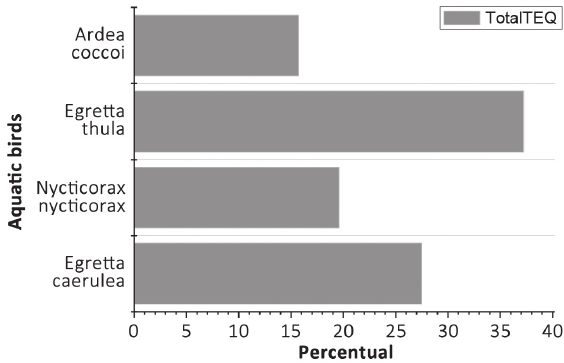
Figure 3 - Contributions of dioxin-like PCBs to Total